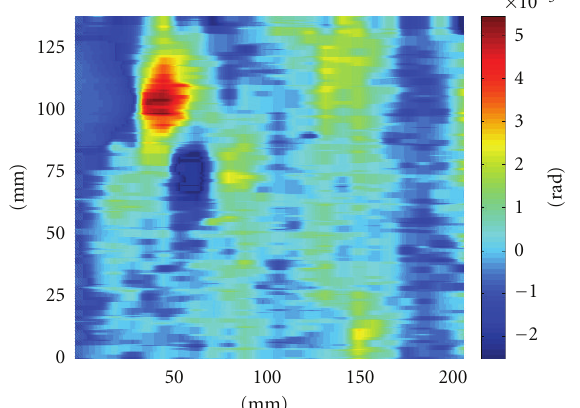
Figure 11: Color map reconstruction of slope di ff erences Δ ϕ (rad) considering vertical